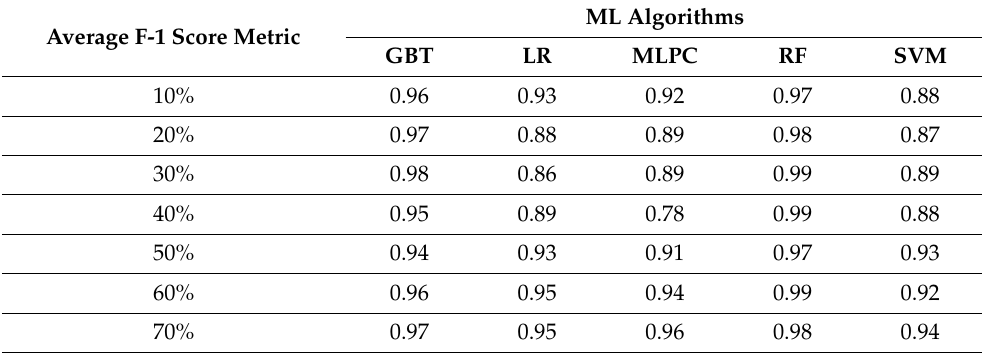
Table 7. Model F-1 results under different networks.